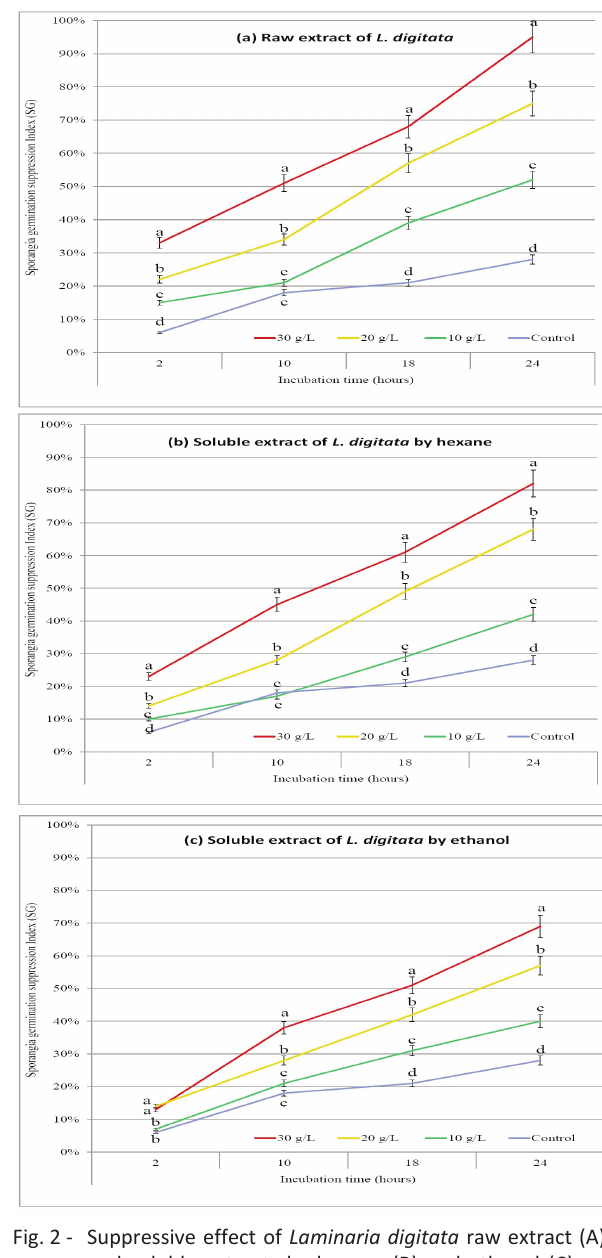
Fig. 2 - Suppressive effect of Laminaria digitata raw extract (A), and soluble extracts by hexane (B) and ethanol (C), on Rhizopus stolonifer sporangia germination suppression index (SG%). The suppressive activity of extracts applied at four different concentrations (including control) was tested after incubation at 22±1°C for 24 hours into micro-well plates filled with PDB medium. Each value, ranging from 0% (no suppression) to 100% (total sup- pression), is the pooled mean±SD (bars) of three replica- tes of 5 glass slides taken from each micro-well. SG% values were collected after 2 h, 10 h, 18 h and 24 h and submitted to regression analysis. For each incubation time, SG% values analysed by one-way ANOVA with dif- ferent letters are significantly different according to DMRT